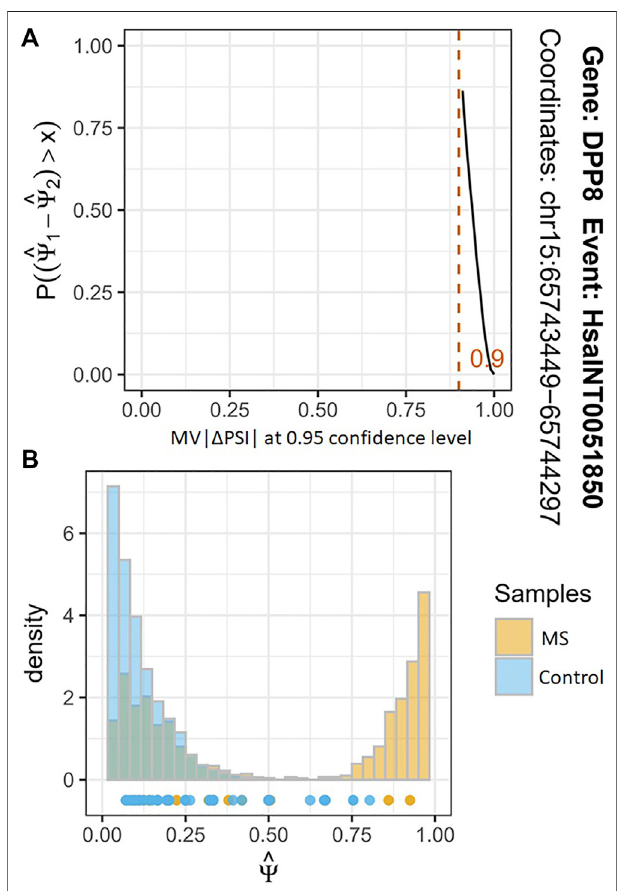
FIGURE 3 | The results of differential analysis of AS event HsaINT0051850. ( A ) The x -axis represents MV| Δ PSI | at a 95% con fi dence level. The y -axis represents the probability of Δ PSI being greater than some magnitudevalueofx.Theredlineindicatesthatthemaximumprobability of Δ PSI of AS event HsaINT0051850 between MS cases and controls is greater than 0.90. ( B ) The histogram shows the two joint posterior distributions over PSI and the points below the histograms estimate for each